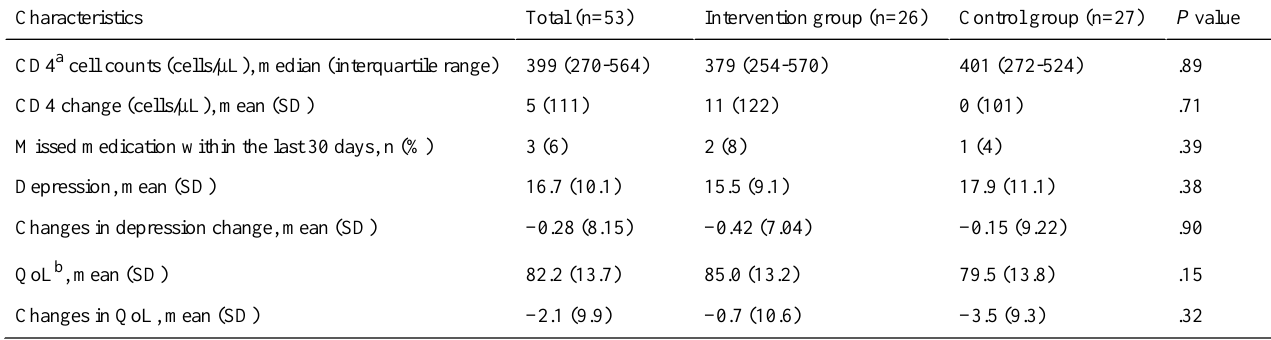
Table 2. Postintervention endpoint analyses and pre-post analyses of the primary